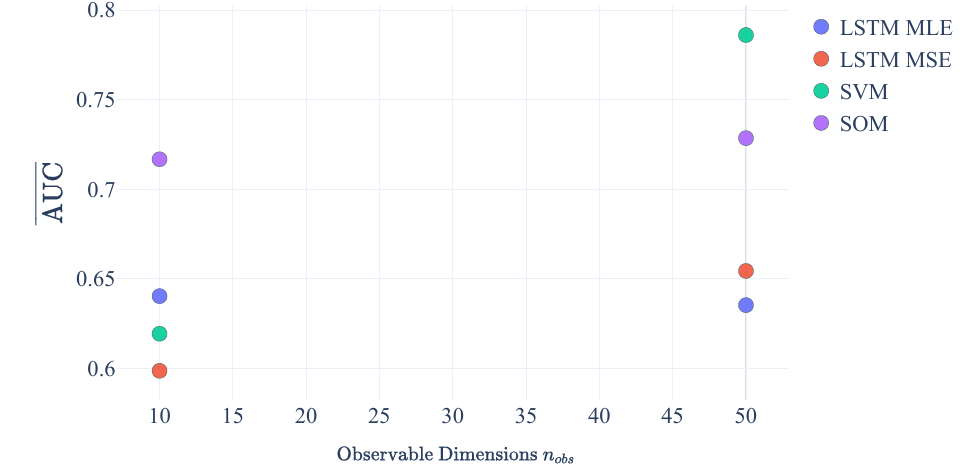
Figure 6. Average AUC for the four Machine Learning (ML) algorithms as function of the number of dimensions in the observation space.